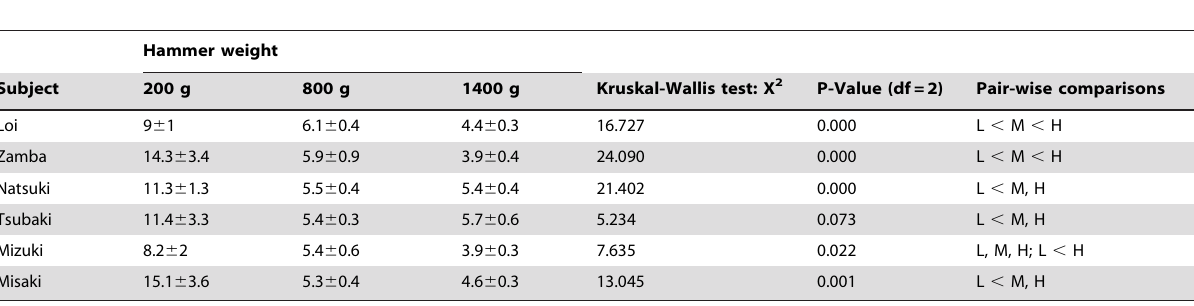
Table 8. Average time ( 6 SE) to solution for all subjects as a function of hammer weight.